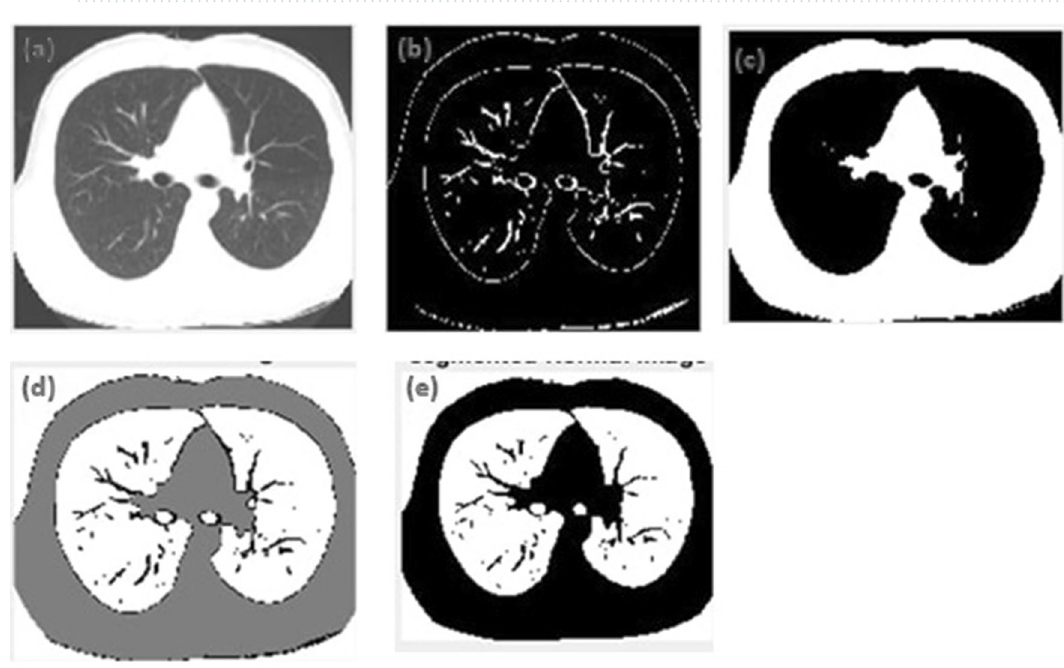
Figure 2. k -means Segmentation of non-COVID CT image ( a ) original non-COVID CT image, ( b ) cluster that depicts the edges detected in the image, ( c ) cluster depicting the surrounding lung region, ( d ) cluster depicting the region of interest, ( e ) depicts final k-means segmented